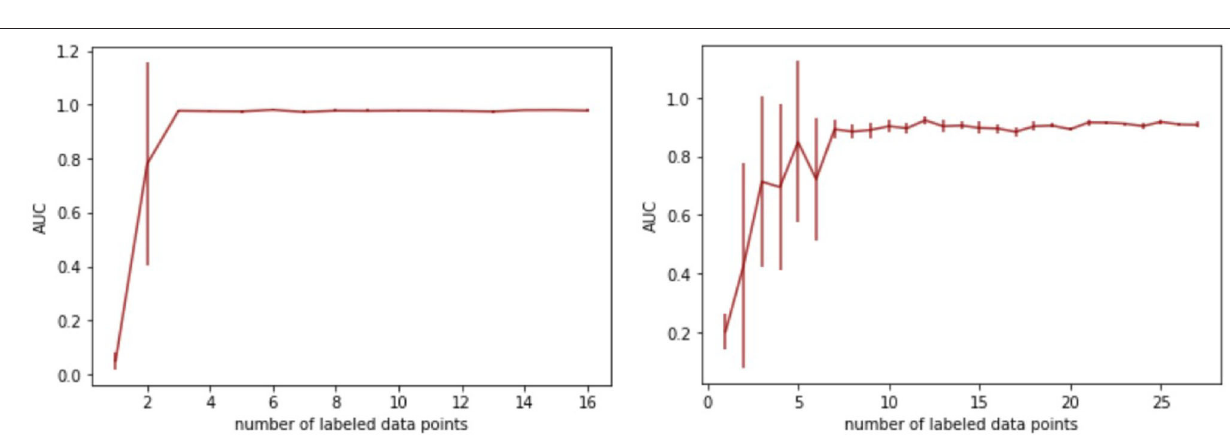
that only seven manual annotations suffice to accurately detect counterattacks with a detection rate (AUC) of over